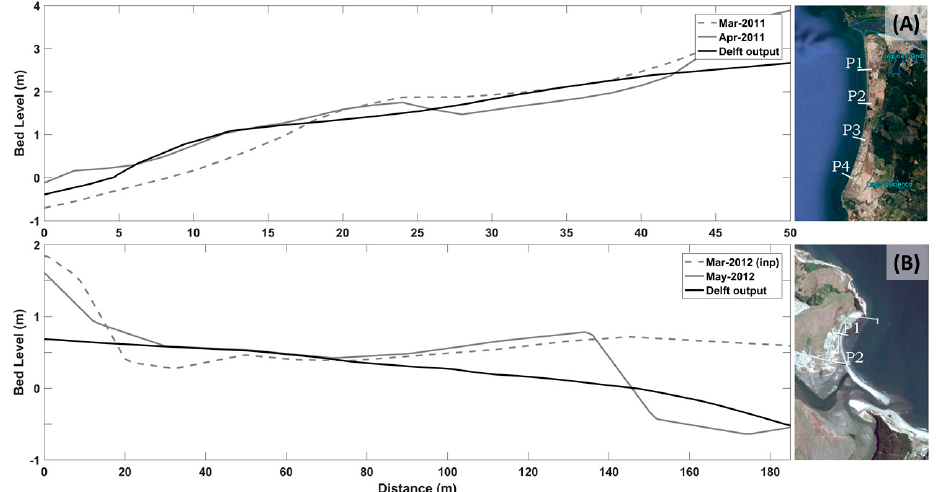
Figure 11. FLOW-MOR module calibration results for ( A ) the Escuadrón profile 2 with: Hs = 3.2 m, Tp = 13.3 s, Thp = 226.1°, ( B ) the Tubul profile 2 with Hs = 5.5 m, Tp = 10.8 s, Thp = 341.4°. The initial profiles and calculated profiles are shown in dashed lines and solid lines, respectively. P1-P4 illustrate the control transects at beaches of Escuadrón and Tubul, respectively.